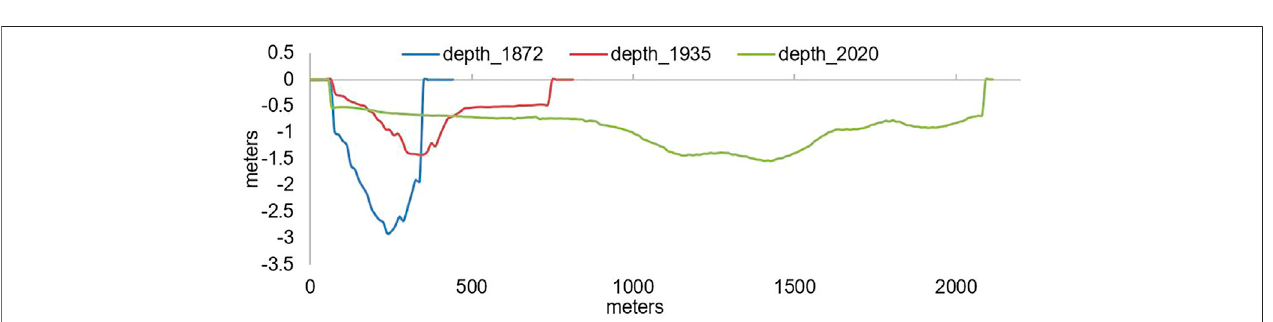
FIGURE 8 | Cross-section of the Carancahua Bay inlet over time (NE-SW direction).